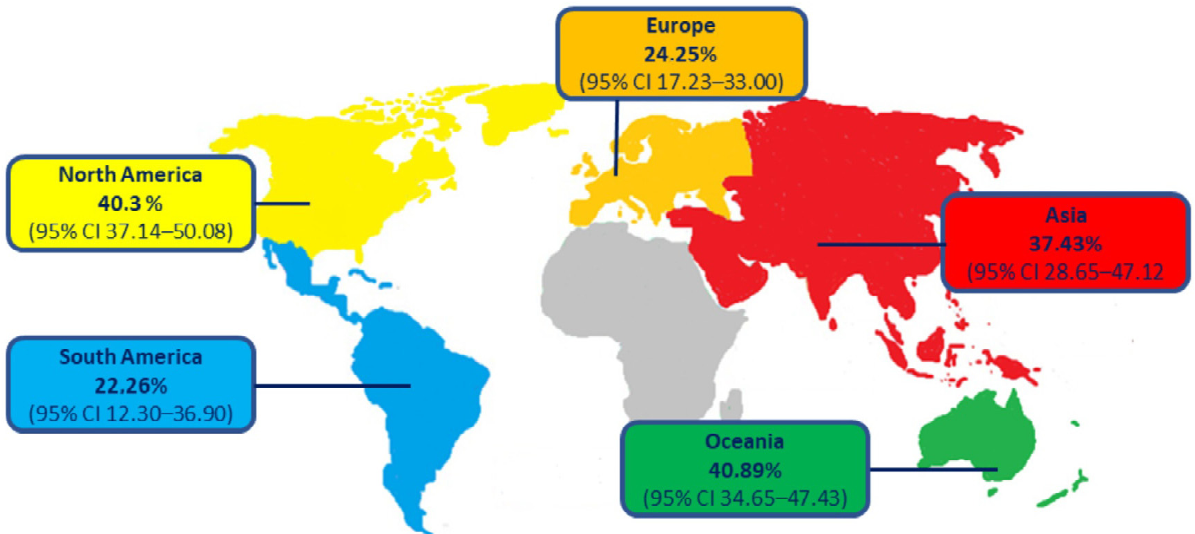
Figure 1. Estimated global prevalence of pediatric MAFLD in overweight or obese children and adolescents.